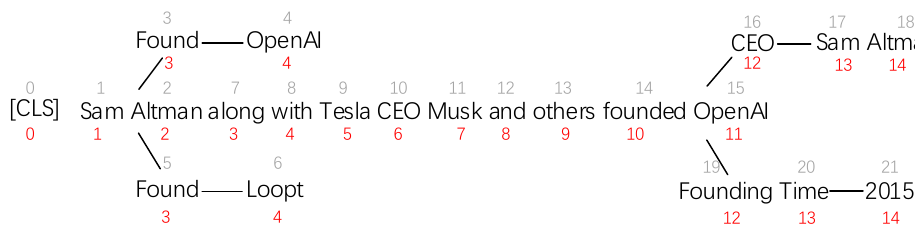
Figure 6. Soft position coding diagram. In the relation tree, the red number is the soft-position index, and the gray is the hard-position index.